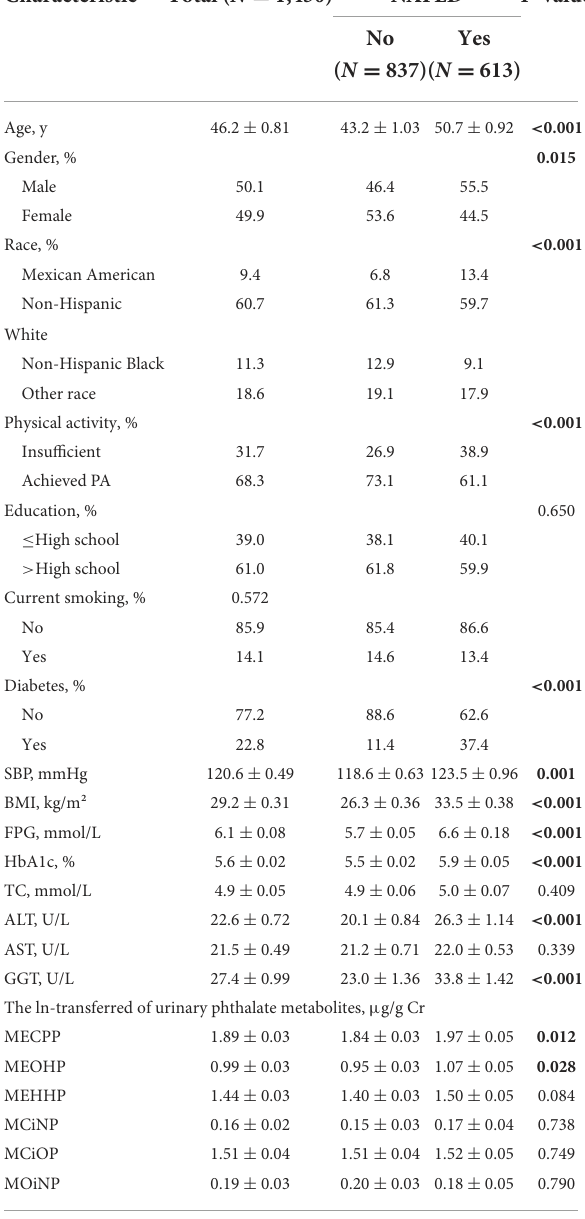
TABLE 1 Population characteristics of American adults with or without NAFLD from NHANES 2017–2018.